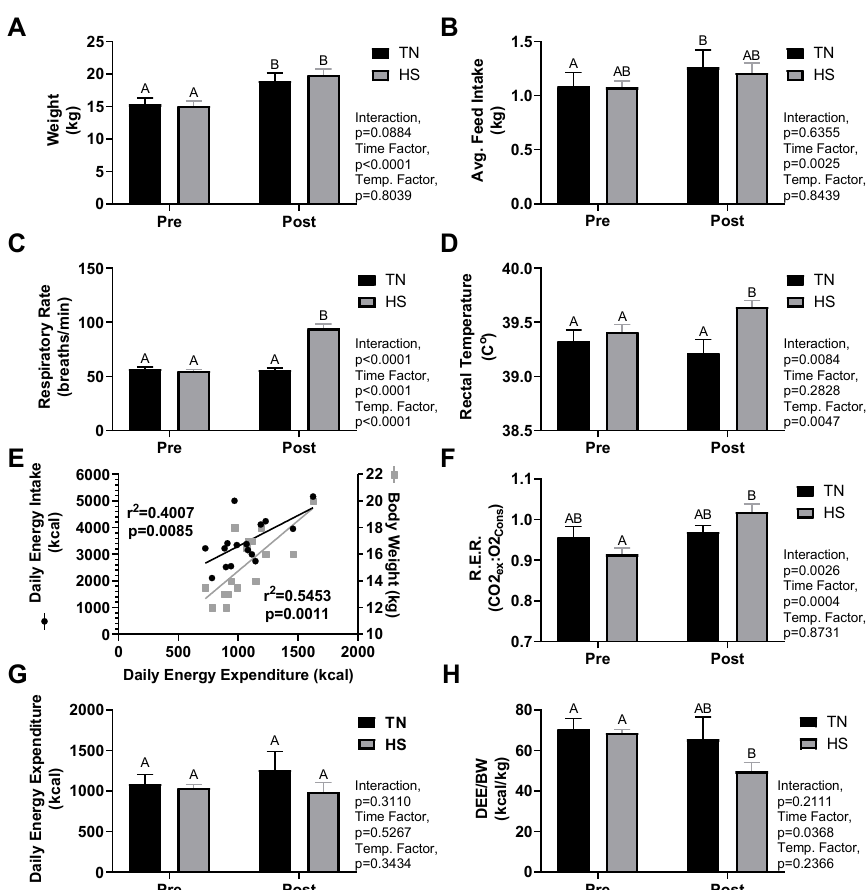
Figure 1. Effect of environmental conditions on growing pig weight ( A ), feed intake ( B ), respiratory rate ( C ), rectal temperature ( D ). Correlation of daily energy expenditure (DEE) to animal body weight and energy intake ( E ). Indirect calorimetry measures on growing pigs of respiratory exchange ratio (RER) ( F ), DEE ( G ), and DEE per body weight (BW) ( H ). Pigs were acclimated under thermoneutral conditions (14 h light/10 h dark, 21.6 ± 0.8 ◦ C, with humidity 46–64%) for five days prior to treatment (Pre). Pigs were then randomly assigned ( n = 8 per group) to thermal neutral (TN, 22.0 ± 0.4 ◦ C, with humidity 43–63%) or heat stress (HS, 33.6 ± 0.5 ◦ C, with humidity 22–40%) treatment groups for five days (Post). Means without a shared letter are significantly different, p < 0.05.